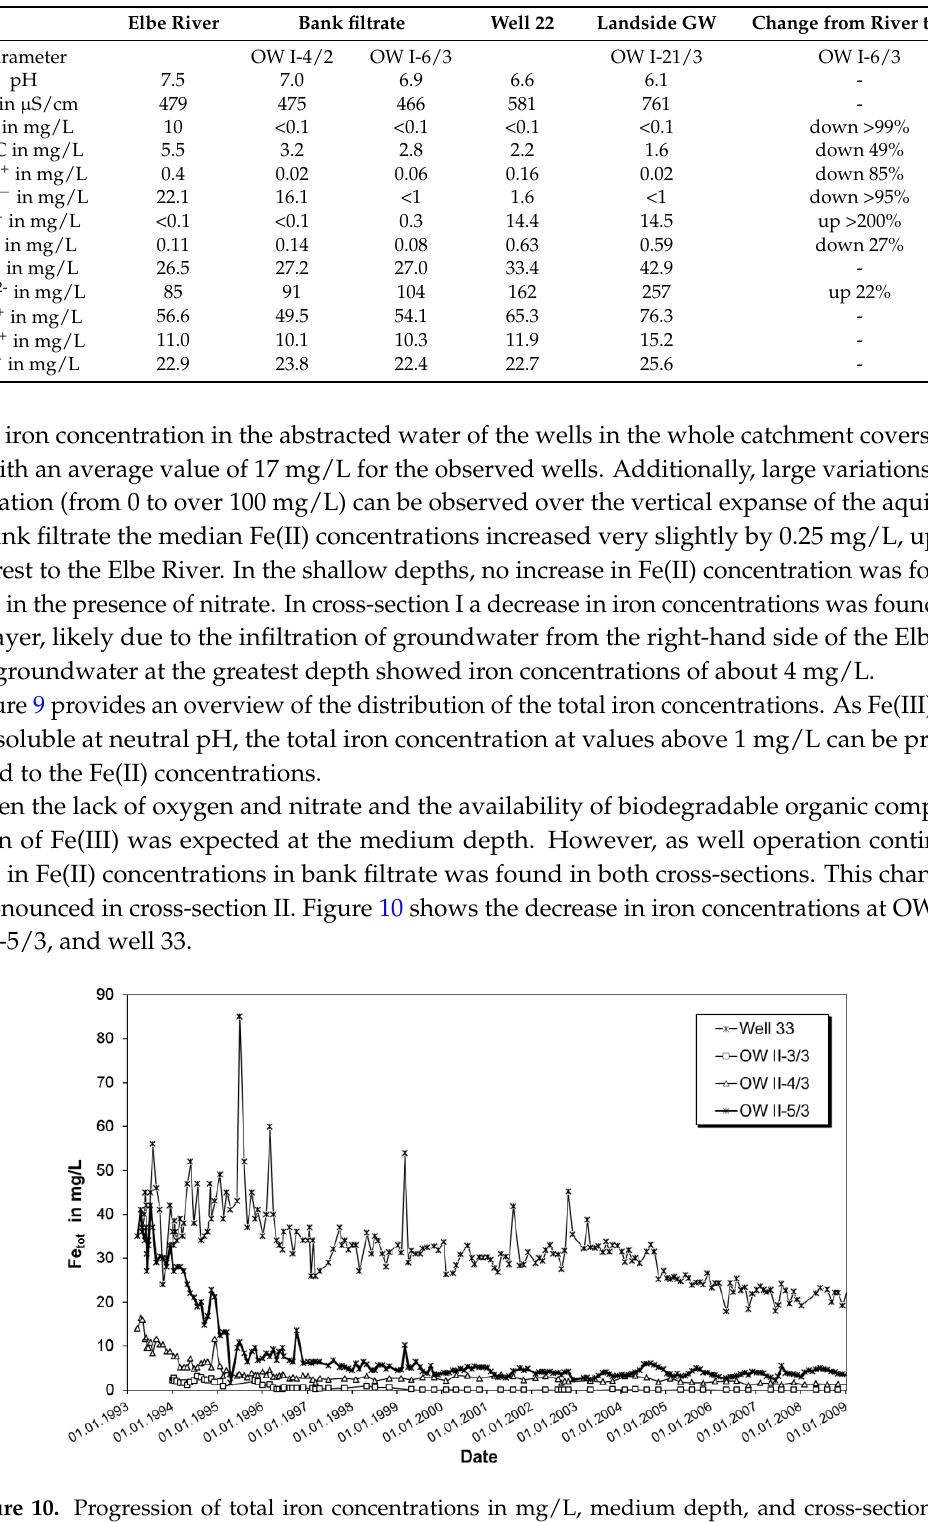
Table 1. Hydrochemical parameters of Elbe River water, bank filtrate (BF) near the river at OW I-4/2 and near the pumping well at OW I-6/3, pumped water from Well 22, and landside groundwater at OW I-21/3 at the RBF site in Torgau, Germany (median values for the period 1995-97, n > 36; location of OW see Figure 9).